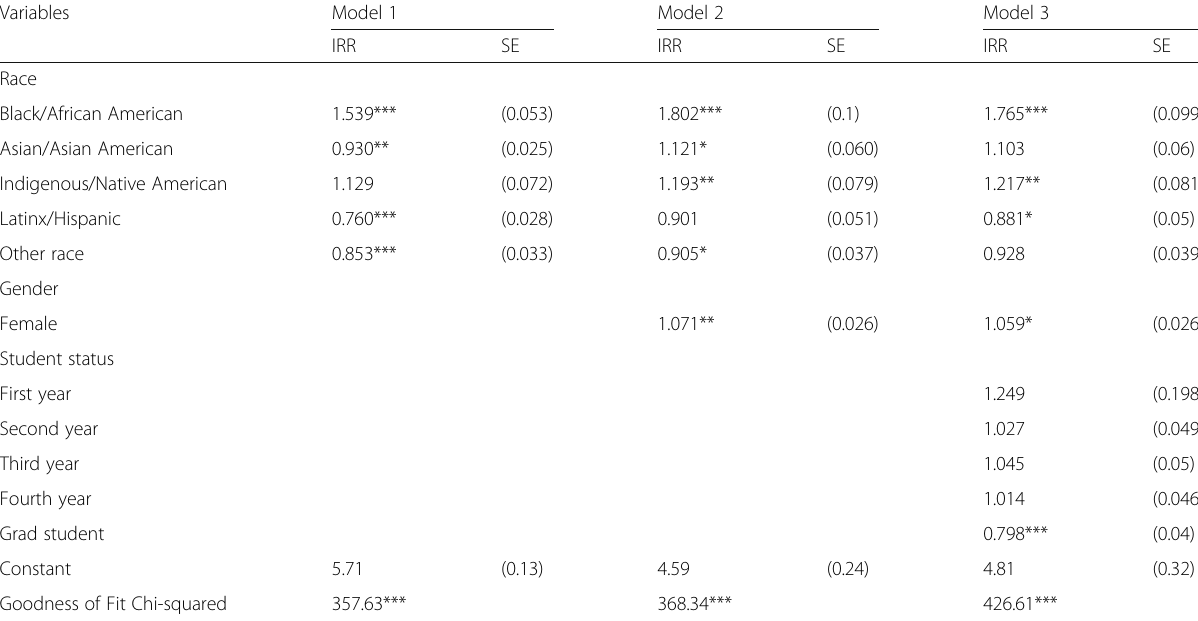
Table 3 Poisson regression predicting campus level microaggressions for all STEM students surveyed